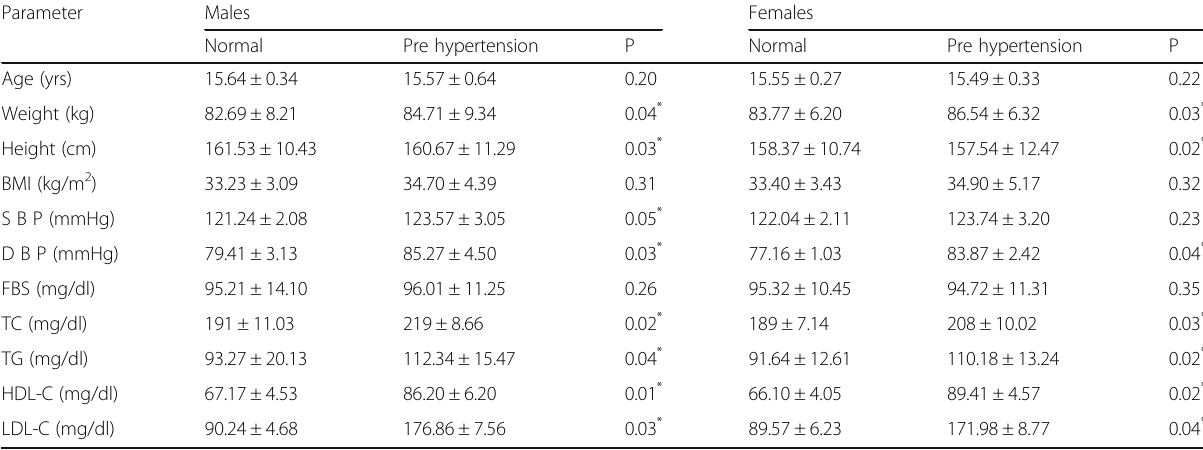
Table 3 Mean ± SD of Age, Weight, Height, BMI and some Biochemical parameters, of males & females obese adolescents Parameter